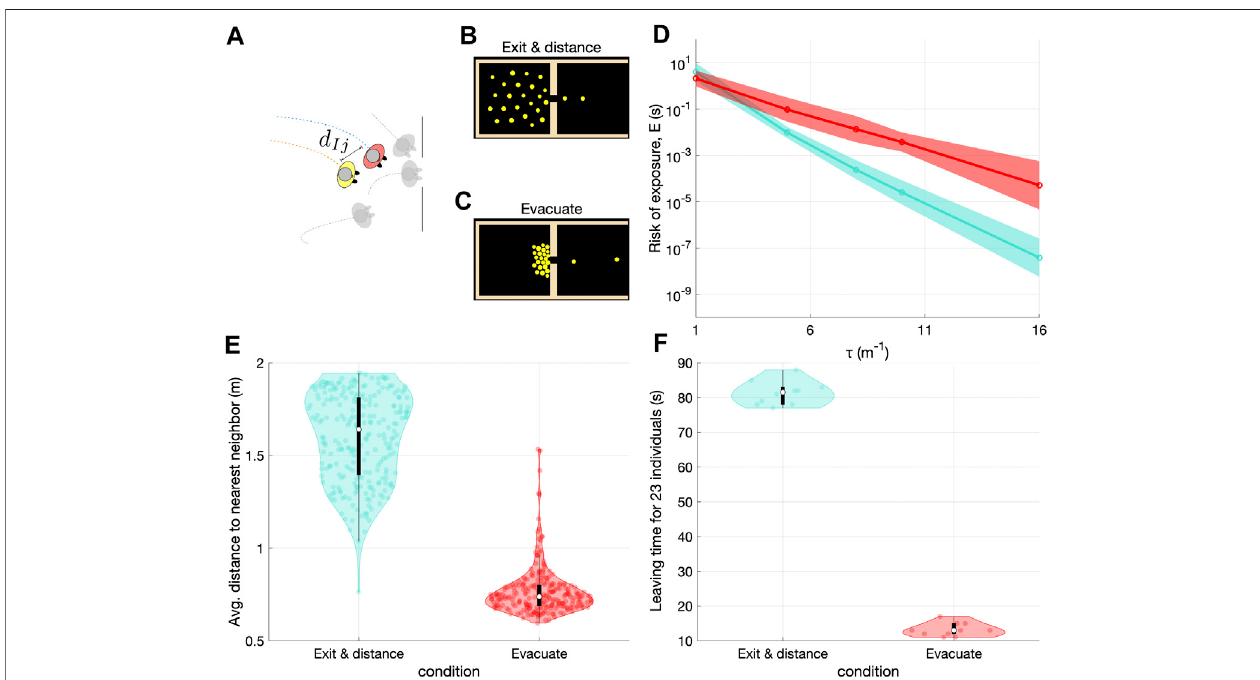
FIGURE 1 | The epidemiological risks from coming close to an individual during an evacuation could outweigh the bene fi ts of being able to quickly leave a room under a potential threat (A) The framework used here combines a pedestrian dynamic model and an exposure model to quantify the risk of exposure during an emergency evacuation (B) and (C) , Snapshots from a simulation of the social force model [8] as 25 agents exit a 10 × 10 m room through a 1-m wide door while maintaining social distance or evacuate without maintaining social distance (D) , Risk of exposure of an individual in the crowd as a function of the decay rate of the transmission; a low value of τ indicates high transmission at larger separation distances (red denotes evacuating, and turquoize identi fi es exiting and social distancing) (E) , Average distance to the nearest neighbor during the two types of simulations performed (red denotes evacuation without distancing, and turquoize identi fi es exiting with distancing) (F) , Leaving time for more than ninety percent of the crowd for the two